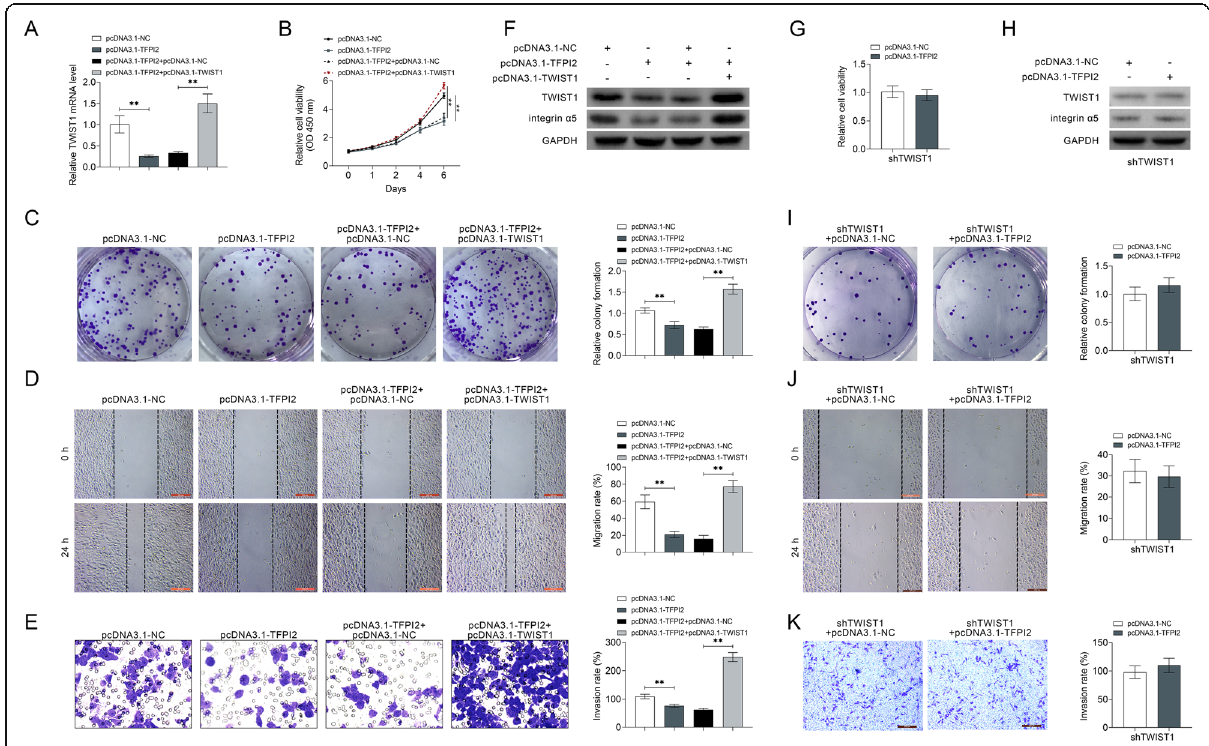
Fig. 5 Inhibition ability of TFPI2 on breast cancer progression was reversed by TWIST1 over-expression. a The mRNA expression of TWIST1 was decreased in cells transfected with pcDNA 3.1-TFPI2, while reversed in cells cotransfected with pcDNA 3.1-TFPI2 and pcDNA 3.1-TWIST1. ** represents pcDNA 3.1-TFPI2 vs. pcDNA 3.1-NC or pcDNA 3.1-TFPI2 + pcDNA 3.1-TWIST1 vs. pcDNA 3.1-TFPI2 + pcDNA 3.1-NC, p < 0.01. b pcDNA 3.1-TFPI2 inhibited cell viability of MDA-MB-453 cells, while cotransfection with pcDNA 3.1-TFPI2 and pcDNA 3.1-TWIST1 promoted the cell viability. ** represents pcDNA 3.1-TFPI2 vs. pcDNA 3.1-NC or pcDNA 3.1-TFPI2 + pcDNA 3.1-TWIST1 vs. pcDNA 3.1-TFPI2 + pcDNA 3.1-NC, p < 0.01. c Transfection with pcDNA 3.1-TFPI2 inhibited cell proliferation of MDA-MB-453 cells, while cotransfection with pcDNA 3.1-TFPI2 and pcDNA 3.1- TWIST1 promoted the cell proliferation. ** represents pcDNA 3.1-TFPI2 vs. pcDNA 3.1-NC or pcDNA 3.1-TFPI2 + pcDNA 3.1-TWIST1 vs. pcDNA 3.1- TFPI2 + pcDNA 3.1-NC, p < 0.01. d Transfection with pcDNA 3.1-TFPI2 inhibited cell migration of MDA-MB-453 cells, while cotransfection with pcDNA 3.1-TFPI2 and pcDNA 3.1-TWIST1 promoted the cell migration. ** represents pcDNA 3.1-TFPI2 vs. pcDNA 3.1-NC or pcDNA 3.1-TFPI2 + pcDNA 3.1-TWIST1 vs. pcDNA 3.1-TFPI2 + pcDNA 3.1-NC, p < 0.01. e Transfection with pcDNA 3.1-TFPI2 inhibited cell invasion of MDA-MB-453 cells, while cotransfection with pcDNA 3.1-TFPI2 and pcDNA 3.1-TWIST1 promoted the cell invasion.. ** represents pcDNA 3.1-TFPI2 vs. pcDNA 3.1-NC or pcDNA 3.1-TFPI2 + pcDNA 3.1-TWIST1 vs. pcDNA 3.1-TFPI2 + pcDNA 3.1-NC, p < 0.01. f Protein expression of TWIST1 and integrin α 5 were down-regulated in cells transfected with pcDNA 3.1-TFPI2, while up-regulated in cells cotransfected with pcDNA 3.1-TFPI2 and pcDNA 3.1- TWIST1. g Cotransfection with pcDNA 3.1-TFPI2 and shTWIST1 had no significant effect on cell viability of MCF7 cells compared to cells cotransfected pcDNA 3.1-NC with shTWIST1. h Cotransfection with pcDNA 3.1-TFPI2 and shTWIST1 had no significant effect on protein expression of TWIST1 and integrin α 5 in MCF7 cells compared to cells cotransfected pcDNA 3.1-NC with shTWIST1. i Cotransfection with pcDNA 3.1-TFPI2 and shTWIST1 had no significant effect on cell proliferation of MCF7 cells compared to cells cotransfected pcDNA 3.1-NC with shTWIST1. j Cotransfection with pcDNA 3.1-TFPI2 and shTWIST1 had no significant effect on cell migration of MCF7 cells compared to cells cotransfected pcDNA 3.1-NC with shTWIST1. k Cotransfection with pcDNA 3.1-TFPI2 and shTWIST1 had no significant effect on cell invasion of MCF7 cells compared to cells cotransfected pcDNA 3.1-NC with